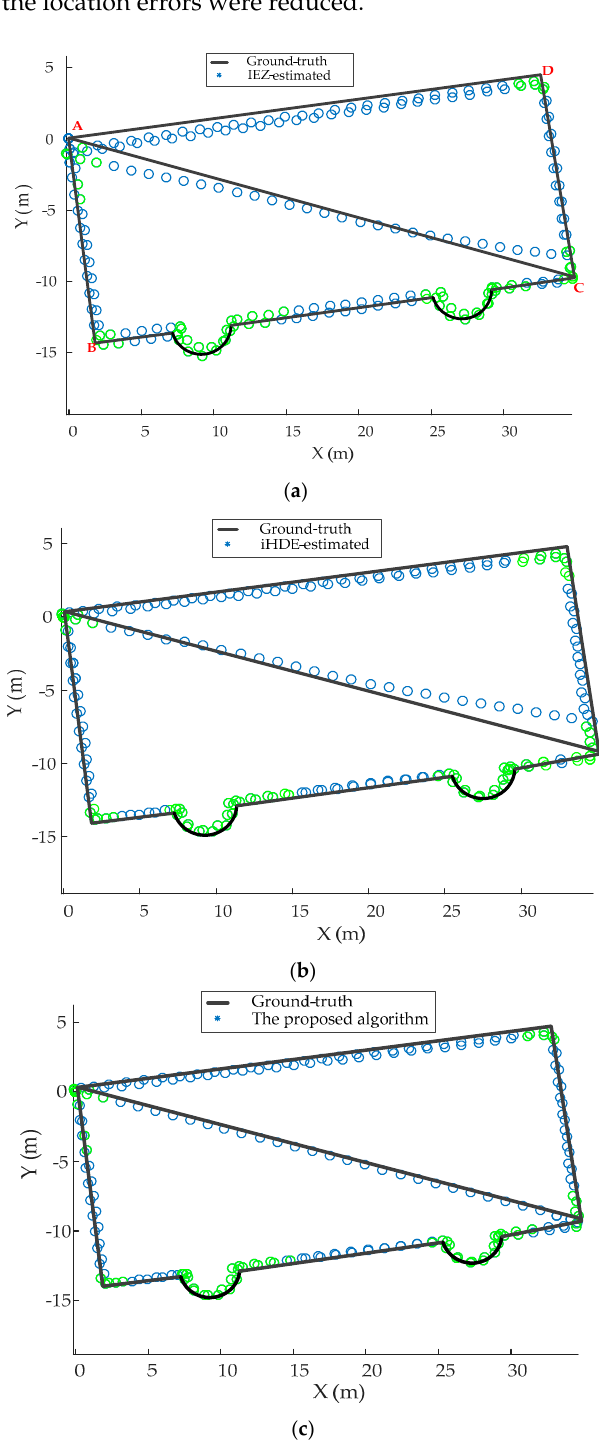
Figure 12. Evaluation of the algorithms. ( a ) Estimated trajectory using the IEZ method. ( b ) Estimated trajectory using the iHDE method. ( c ) Estimated trajectory using the proposed heading correction method. The green circles represent the curved walking steps. Table 4. The pre-defined dominant directions of the different straight path segments.